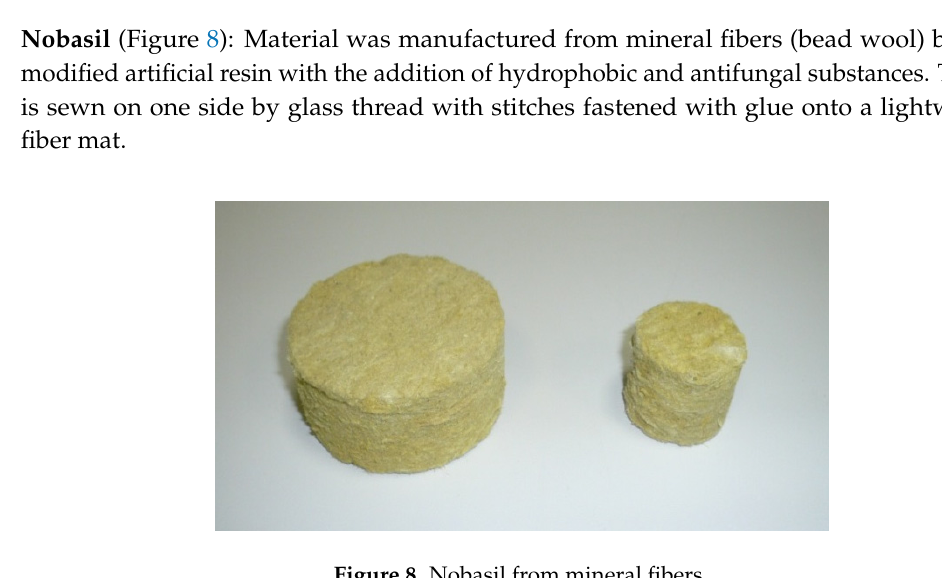
Figure 7. Recycled rubber after pressing.